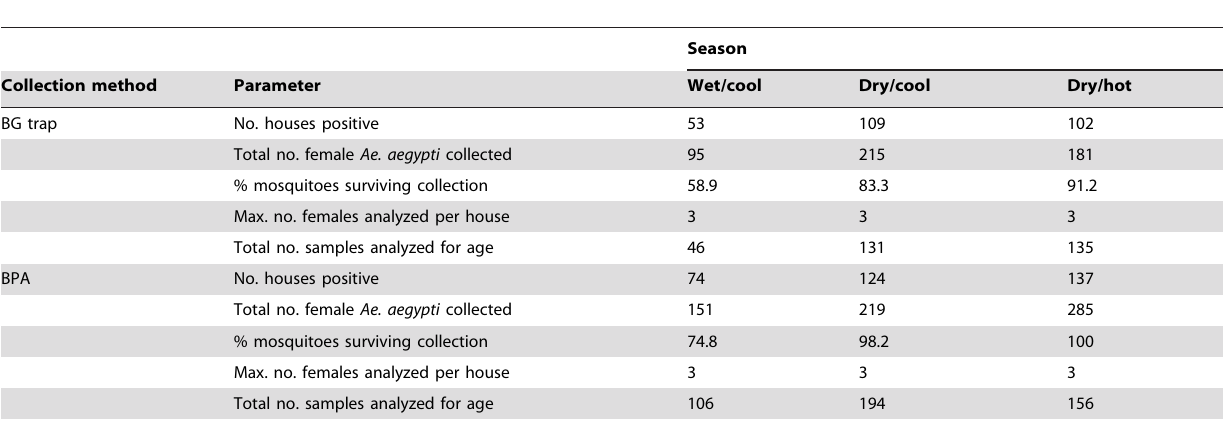
Table 2. Collections of wild Aedes aegypti samples from Tri Nguyen village over three seasons using BG trap and backpack aspirator (BPA) collection